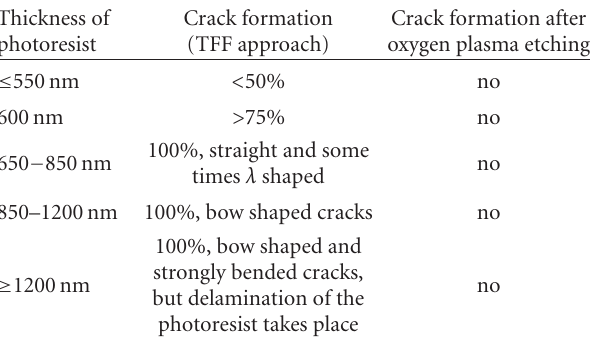
Table 1: Summary of the TFF approach: Success statistics for a 10 μ m sized gap width of resist. From approx.100 chips, 80 were fabricated with a 100% success rate at the optimized photoresist thickness between 850–1200